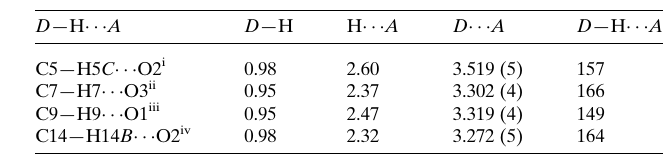
Table 1 Hydrogen-bond geometry (A˚ , (cid:2) ).